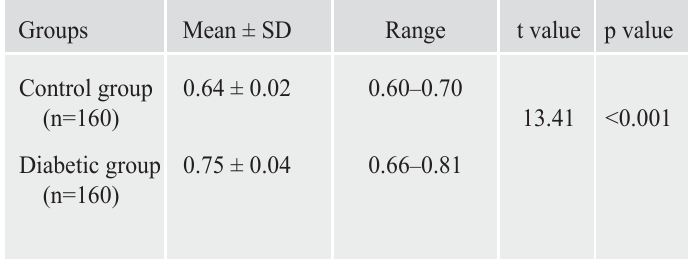
Table III: Comparison of retinal arterial mean resistive index (RI) between 160 control eyes and 160